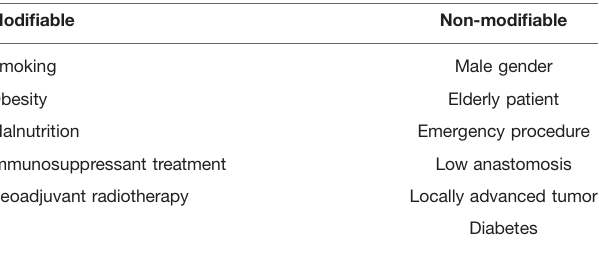
TABLE 1 | Modi fi able and non-modi fi able risk factors examples from clinical studies (11 – 13). Modi fi